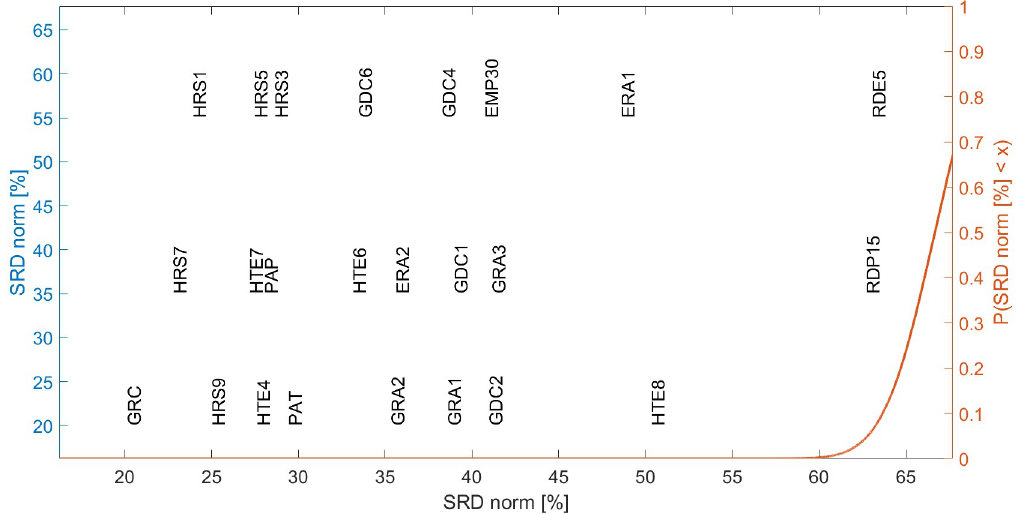
Fig 4. Selected variables from SRD according to their relevance in measurement. (The descriptions of variables are shown in S3 Appendix).